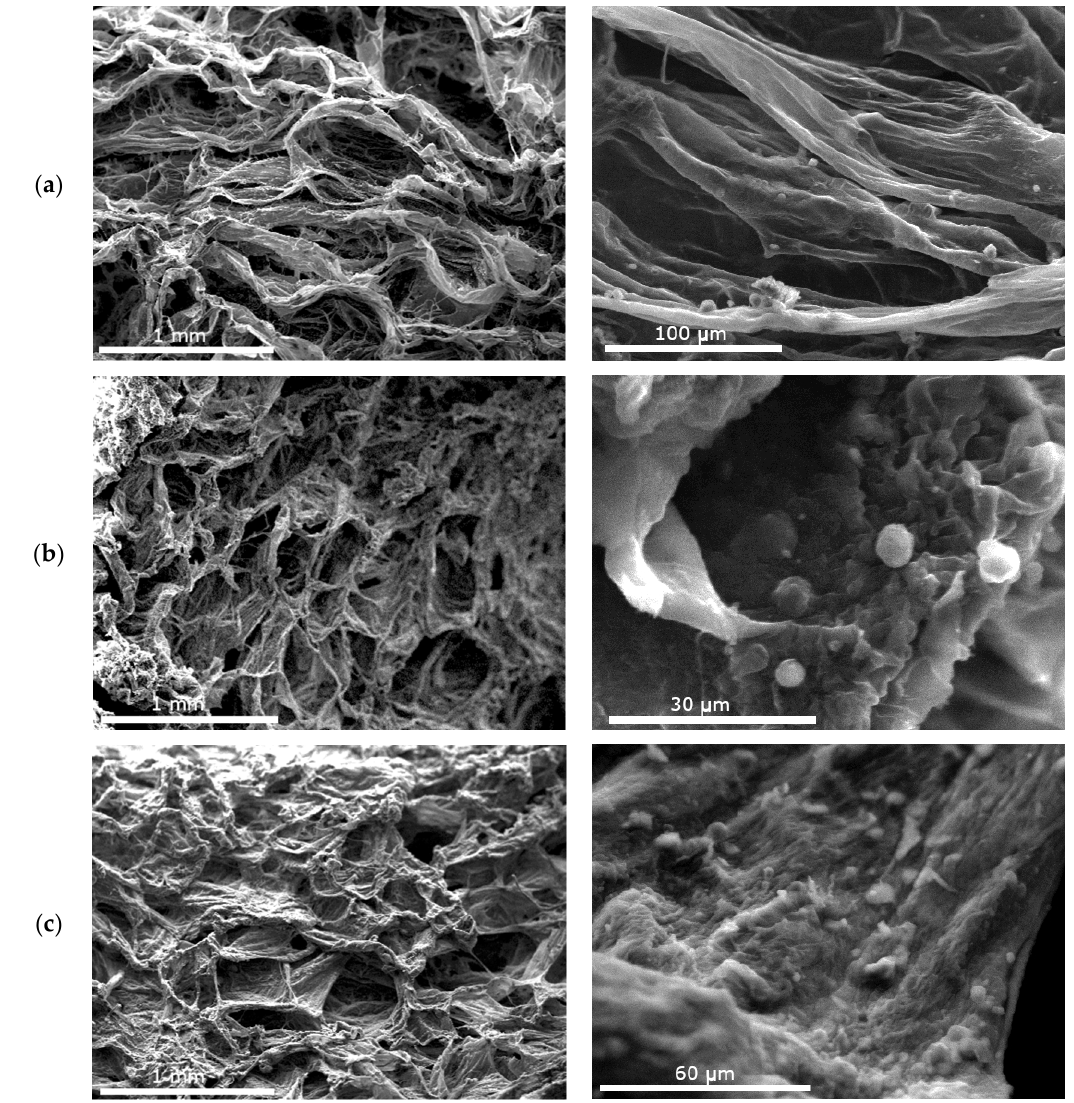
Figure 4. SEM micrographs of the prepared patches in di ff erent magnifications: ( a ) Coll-CS Cur, ( b ) Coll-Cross-CS Cur, ( c ) Coll-Cross-Hep-CS